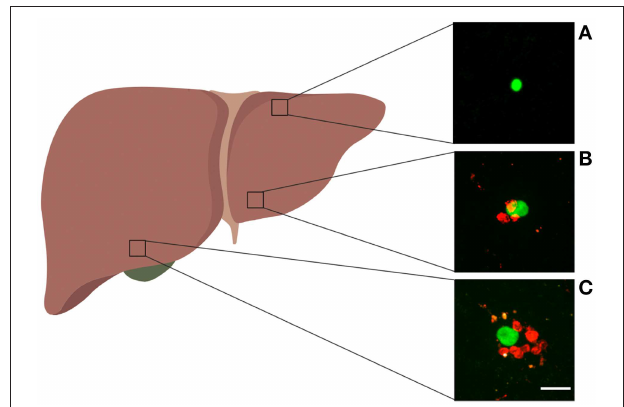
FIGURE 1 | Examples of Plasmodium liver stages and clusters of activated CD8 T cells. Experiments were performed as shown in Figure S1A for control PyTCR cells, and examples of GFP-expressing malaria liver stages found in different parts of the liver are shown. (A) Liver stage with no CD8 T cells around, (B) liver stage with three CD8 T cell cells within 40 µ m radius, (C) liver stage with 8 CD8 T cells within 40 µ m radius. The white bar in panel C is 20 µ m. Image of the liver was made with